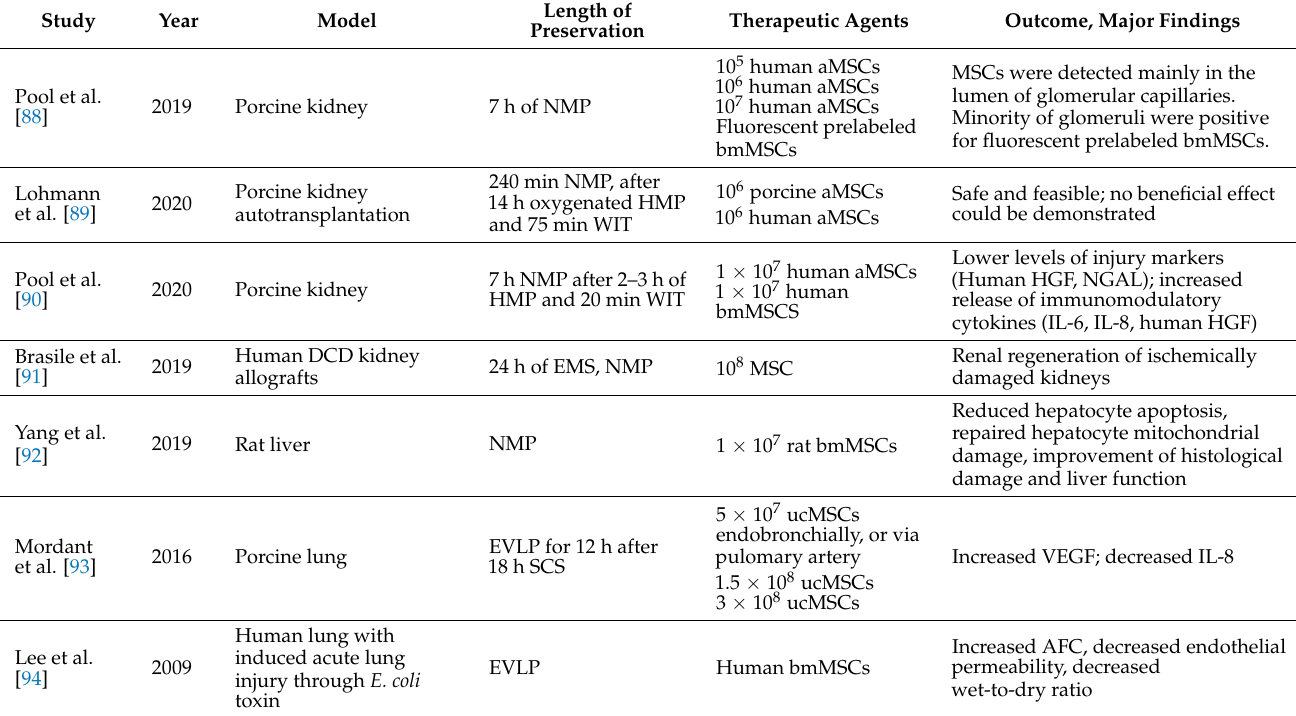
Figure 3. Normothermic machine perfusion as a novel platform to treat and regenerate organs outside the human body. MSCs can be delivered directly into the vasculature of the liver by addition into the circulating perfusate. This concept may help to overcome issues of MSC trafficking and homing (Figure created with https://biorender.com, accessed on March 21st, 2021). Table 1. Overview of studies investigating safety, feasibility, and efficacy of MSCs in machine perfusion. To identify articles reporting on MSC therapy during ex situ machine perfusion, a PubMed search using the search terms “mesenchymal stem cell” and “transplantation” and “machine perfusion” was performed on 10 March 2021, thereby identifying 7 studies.